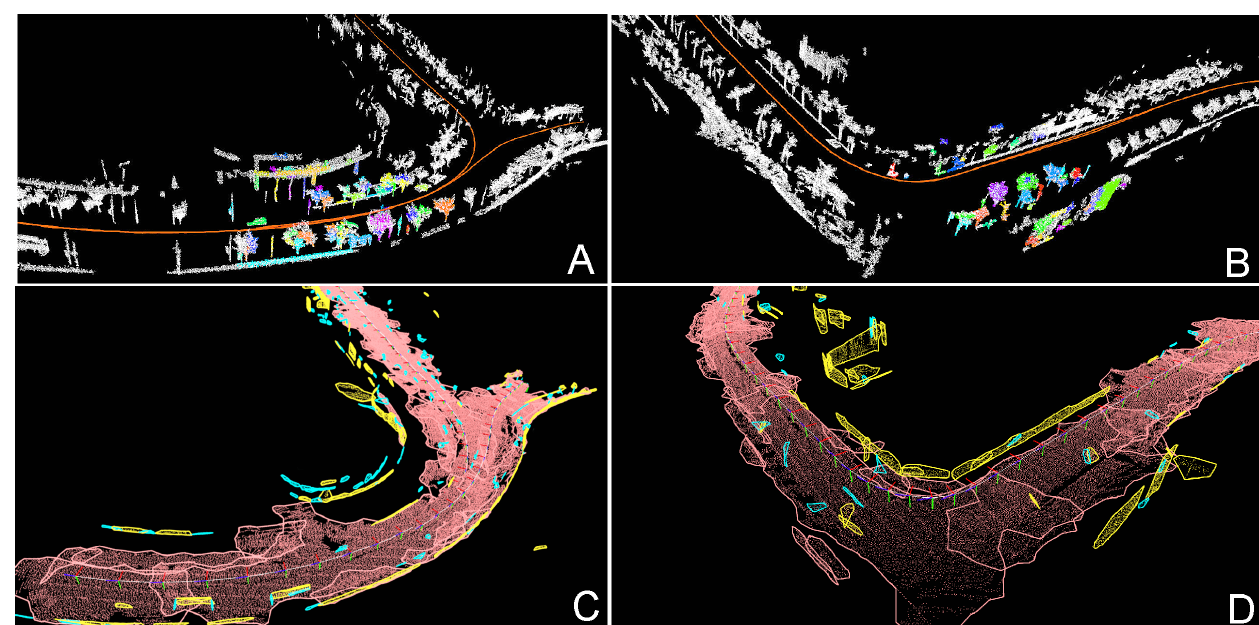
Figure 11. Detecting loop closures with the SegMap approach in the MulRan dataset sequence ( A , B ). Local maps of semantically segmented point clouds visualized in different colors are matched to a global map of point cloud segments shown in white. The same areas are visualized as maps of high-level features ( C , D ), with orange planar patches for the ground plane and the approximately vertical features shown in yellow (larger walls) and cyan (small planar